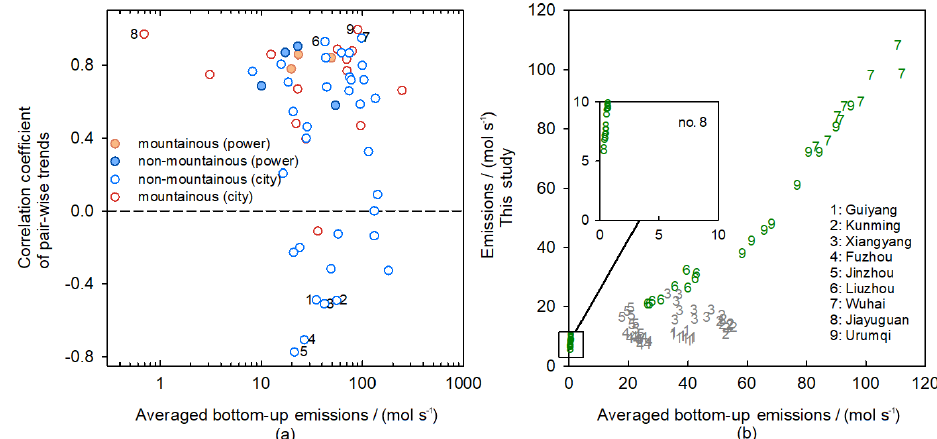
Figure 6. (a) Correlation coefficients of the pair-wise trends between the bottom-up anthropogenic and fitted NO x emissions for all selected sites during 2006 ∗ to 2014 ∗ . The results for sites with correlation coefficients less than − 0.4 or larger than 0.9 are indicated by digits. (b) Scatter plots of the fitted NO x emissions for investigated cities versus bottom-up anthropogenic emission inventories during 2006 ∗ to 2014 ∗ . Urban emissions from bottom-up inventories are integrated over an area of 40km × 40km (see Sect. 2.2). Results with correlation coefficients less than − 0.4 or larger than 0.9 are color coded by gray and green,